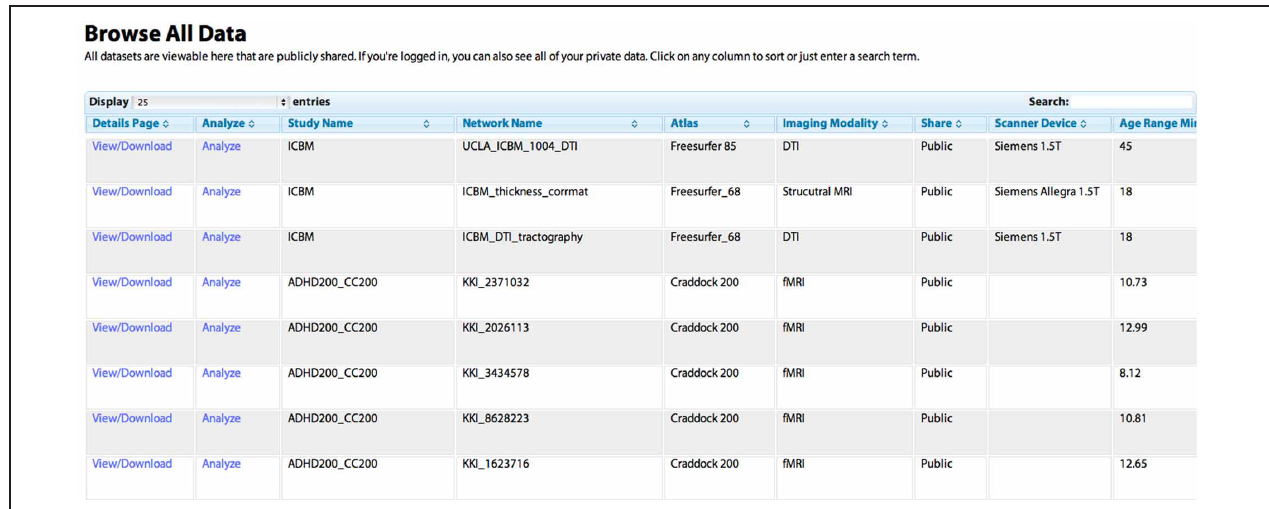
are shown. The “View/Download” link takes the user to a “profile” page for the individual network that contains more detailed information (see Figure 5 ). The “Analyze” link takes the user to the “Analyze Network” page with the “Study Name” and “Network Name” pre-selected, allowing the user to run a network analysis simply by clicking “Analyze.”